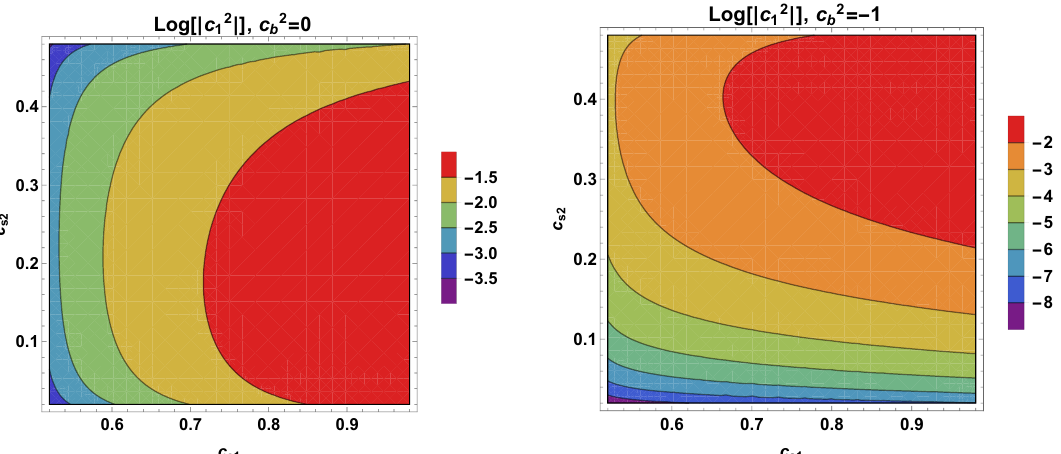
logarithmic contour plot for c 2 Figure 4. c 2 1